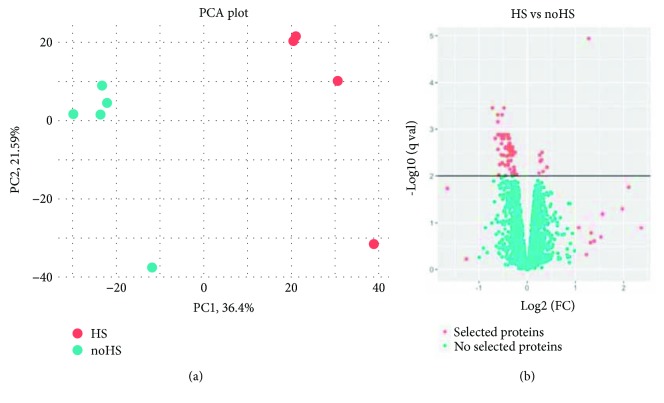
Quantitative proteomic comparison of TRIMEL lysates with (HS) and without (no-HS) heat shock conditioning. (a) Principal components analysis (PCA). (b) Volcano plot representation of moderated t-test analysis. Each point represents one protein plotted by log2 fold change (FC, average of four samples) versus minus logarithm of the q-value (Bemjamini-Hochberg corrected p value). The horizontal bar represents a q-value cutoff of 0.01. Red dots indicate the proteins selected for further analysis.